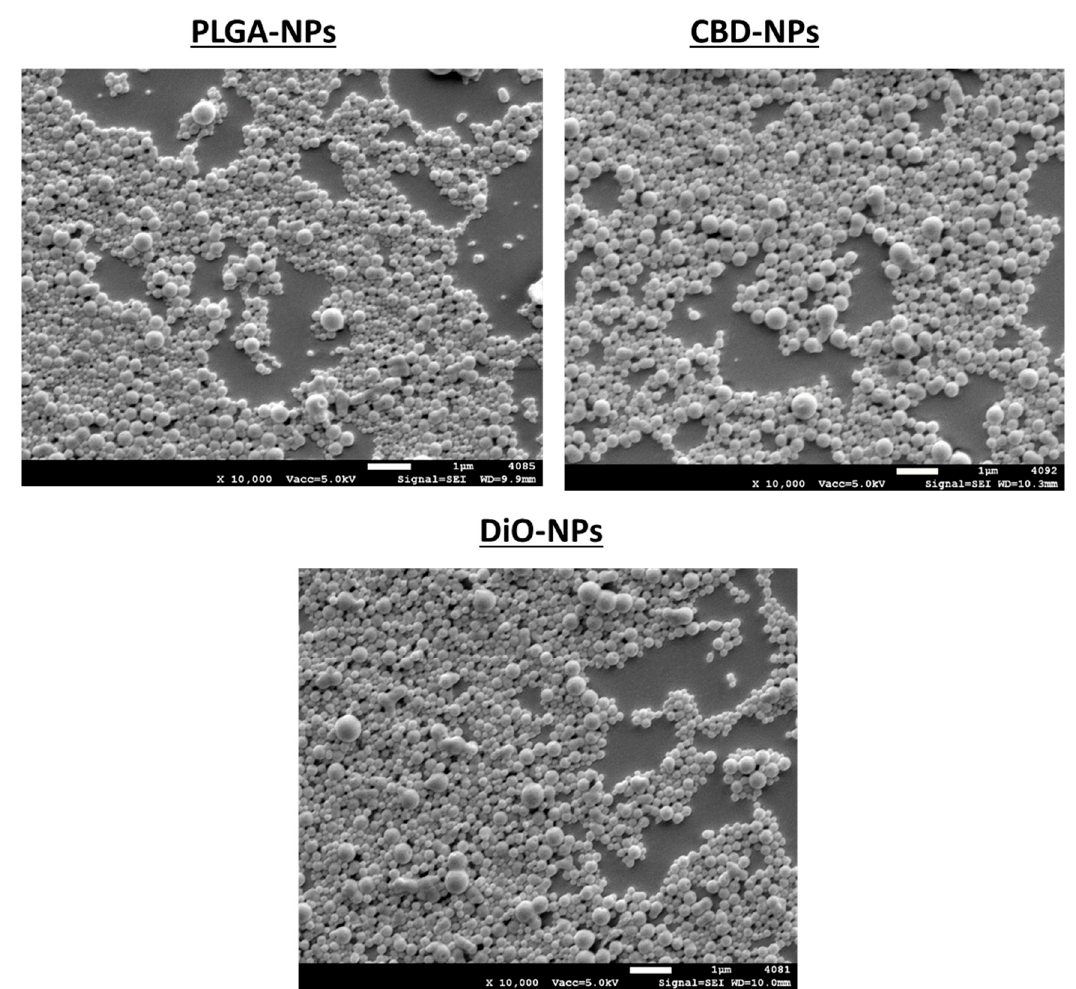
Figure 1. SEM images of unloaded, cannabidiol (CBD)-loaded and 3,3’-dioctadecyloxacarbocyanine perchlorate (DiO)-loaded nanoparticles. PLGA: poly-lactic- co -glycolic acid. The DSC thermogram of pure CBD denoted a sharp endothermic peak at 69.68 °C that